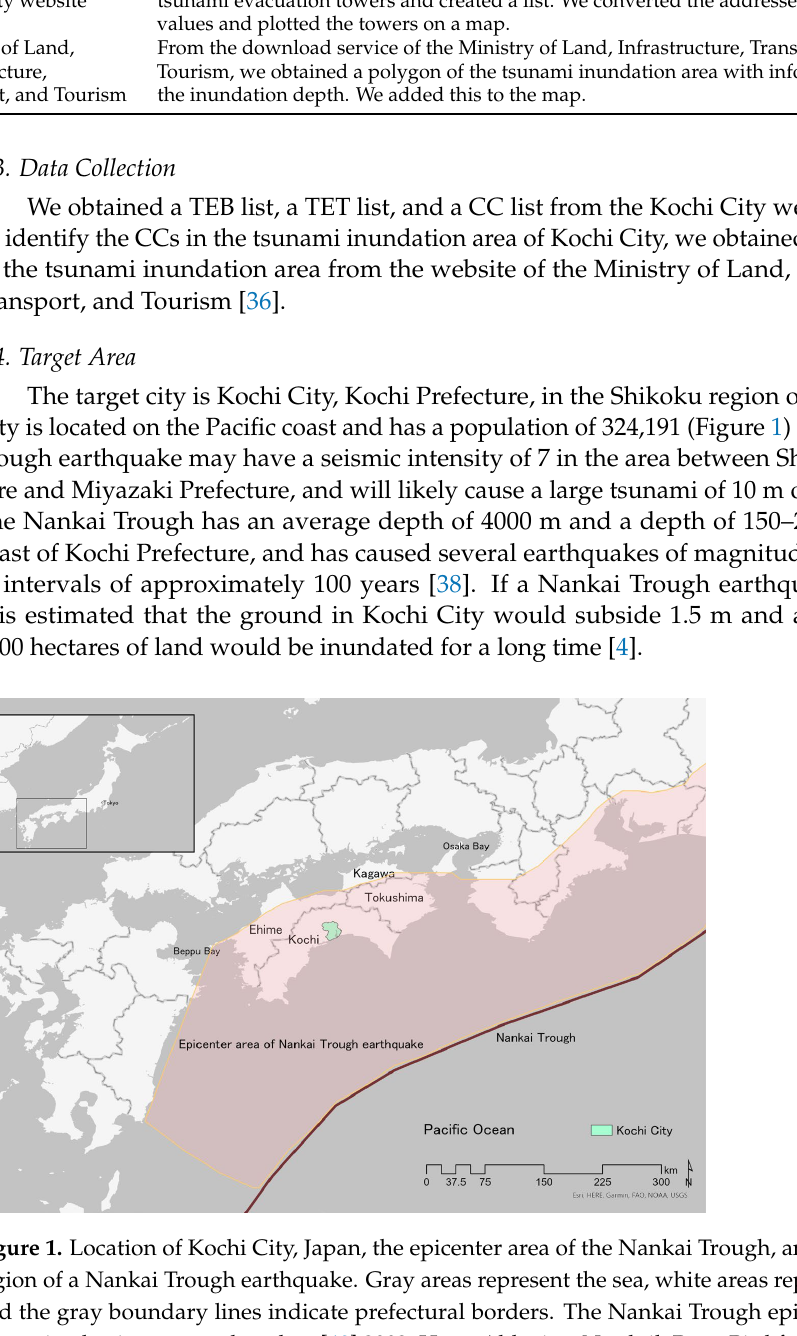
Table 1. The types and sources of data used for analysis.